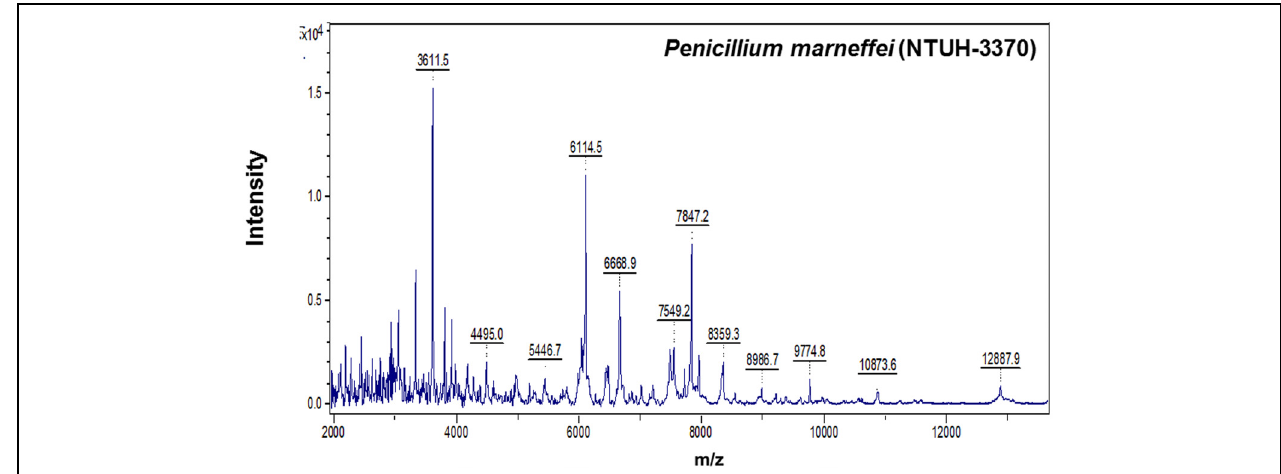
FIGURE 2 | Spectra of Penicilliun marneffei (NTUH-3370) generated by the MALDI-TOF Bruker Biotyper. The absolute intensities of the ions are shown on the y axis, and the masses ( m/z ) of the ions are shown on the x axis. The m/z values represent the mass-to-charge ratio.